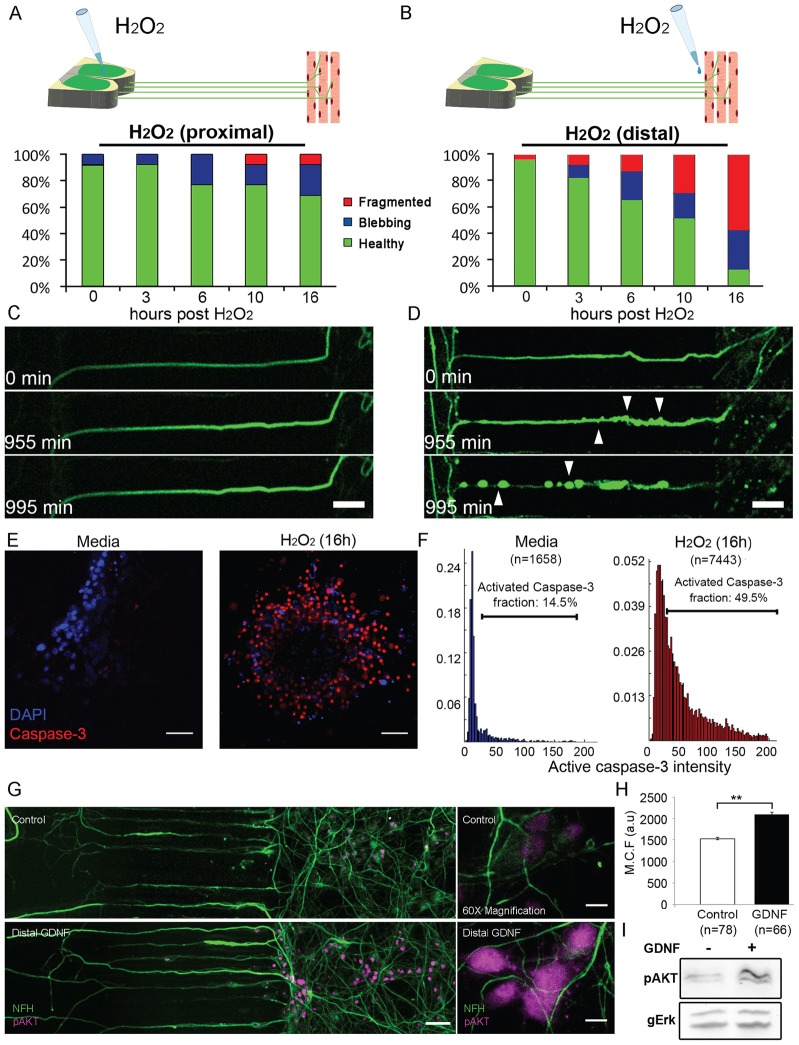
Long distance progression of oxidative stress damage and GDNF-mediated pro-survival signaling. (A,B) The graphs show the fraction of healthy, blebbing and fragmented axons after application of 1 mM H2O2 in (A) the neuronal/proximal or (B) muscle/distal compartment. (C,D) Timecourse images of HB9::GFP (green) axon degeneration. Images were taken with an epifluorescent microscope with a 10× objective. Arrowheads denote sites of axonal blebbing. Scale bars: 50 µm. (E) Epifluorescent, 20× objective images of immunostained spinal cord explants showing activated caspase-3 (red) and DAPI (blue) in the soma of control versus H2O2-treated spinal cord explants after 16 h. Scale bars: 100 µm. (F) Distribution of mean caspase-3 intensities in DAPI-positive ROIs. The caspase-3 intensity value of 40 was chosen as a cutoff between cell bodies with activated and inactivated caspase-3. (G) Stitched low-magnification image of the proximal, microgroove and distal areas of neurons in the microfluidic chamber, taken with a 20×objective. Images show phosphorylated Akt (pAkt)- and NFH-labeled neurons at 3 h after medium or GDNF treatment in the distal compartment. Scale bar: 50 µm. The right panel shows 60× objective images of neuronal soma in the proximal compartment. Scale bar: 10 µm. (H) Comparison of mean pAkt levels in cell bodies of GDNF-treated versus control-treated neurons. A total of ten fields per treatment were analyzed, containing 4–10 cells each. n, number of cells analyzed. Data show the mean±s.e.m.; **P<0.01 (one-tailed Student's t-test). (I) Representative western blot image of pAkt and gERK (total Erk1/2 as loading control) of lysate from the soma compartment of distal GDNF-treated versus medium-treated cultures.